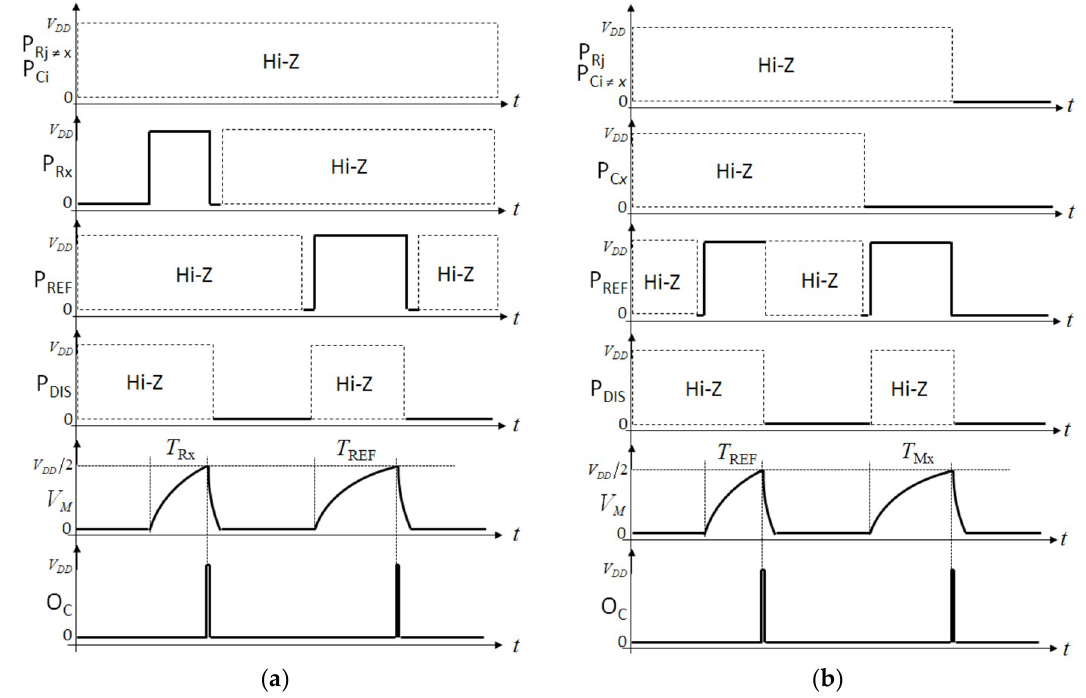
Figure 3. Operation of the microcontroller‐based interface: ( a ) measurement cycle for the resistive sensor R x (the charging times of C M through R x and R REF are sequentially measured); ( b ) measurement cycle of the capacitive sensor C x (the charging times of C M and of C x + C M through R REF are sequentially measured).